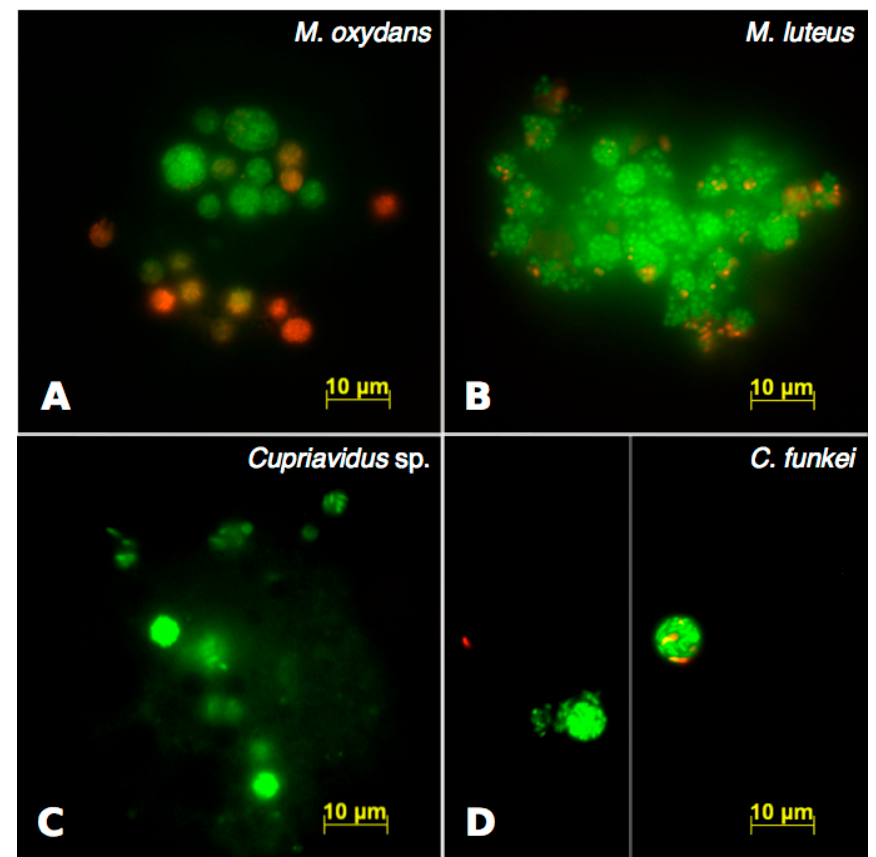
Figure 3. Bacterial cells are viable in pellets produced by Tetrahymena . Pellets produced in a co-culture of T. pyriformis and M. oxydans ( A ), M. luteus ( B ), or Cupriavidus sp. ( C ). Pellets produced in a co-culture of T. thermophila and C. funkei ( D ). Panel ( D ) is a composite of 2 different images, as no single image contained more than one pellet. Samples were stained with LIVE/DEAD bacterial viability stain. All the pictures were taken at 630× magnification and are merge images of SYTO 9 (green; viable cells) and propidium iodide (red; dead cells) fluorescence.